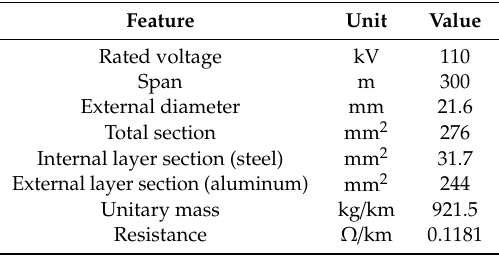
Table 1. Features of the ACSR 240 / 30 mm 2 .